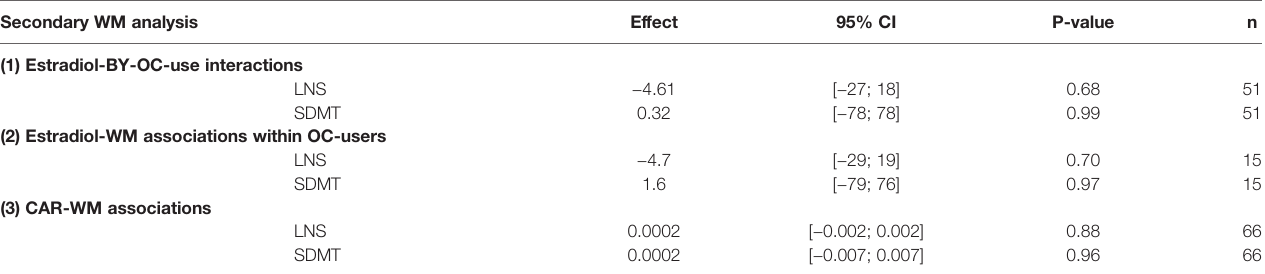
TABLE 3 | Results from secondary working memory